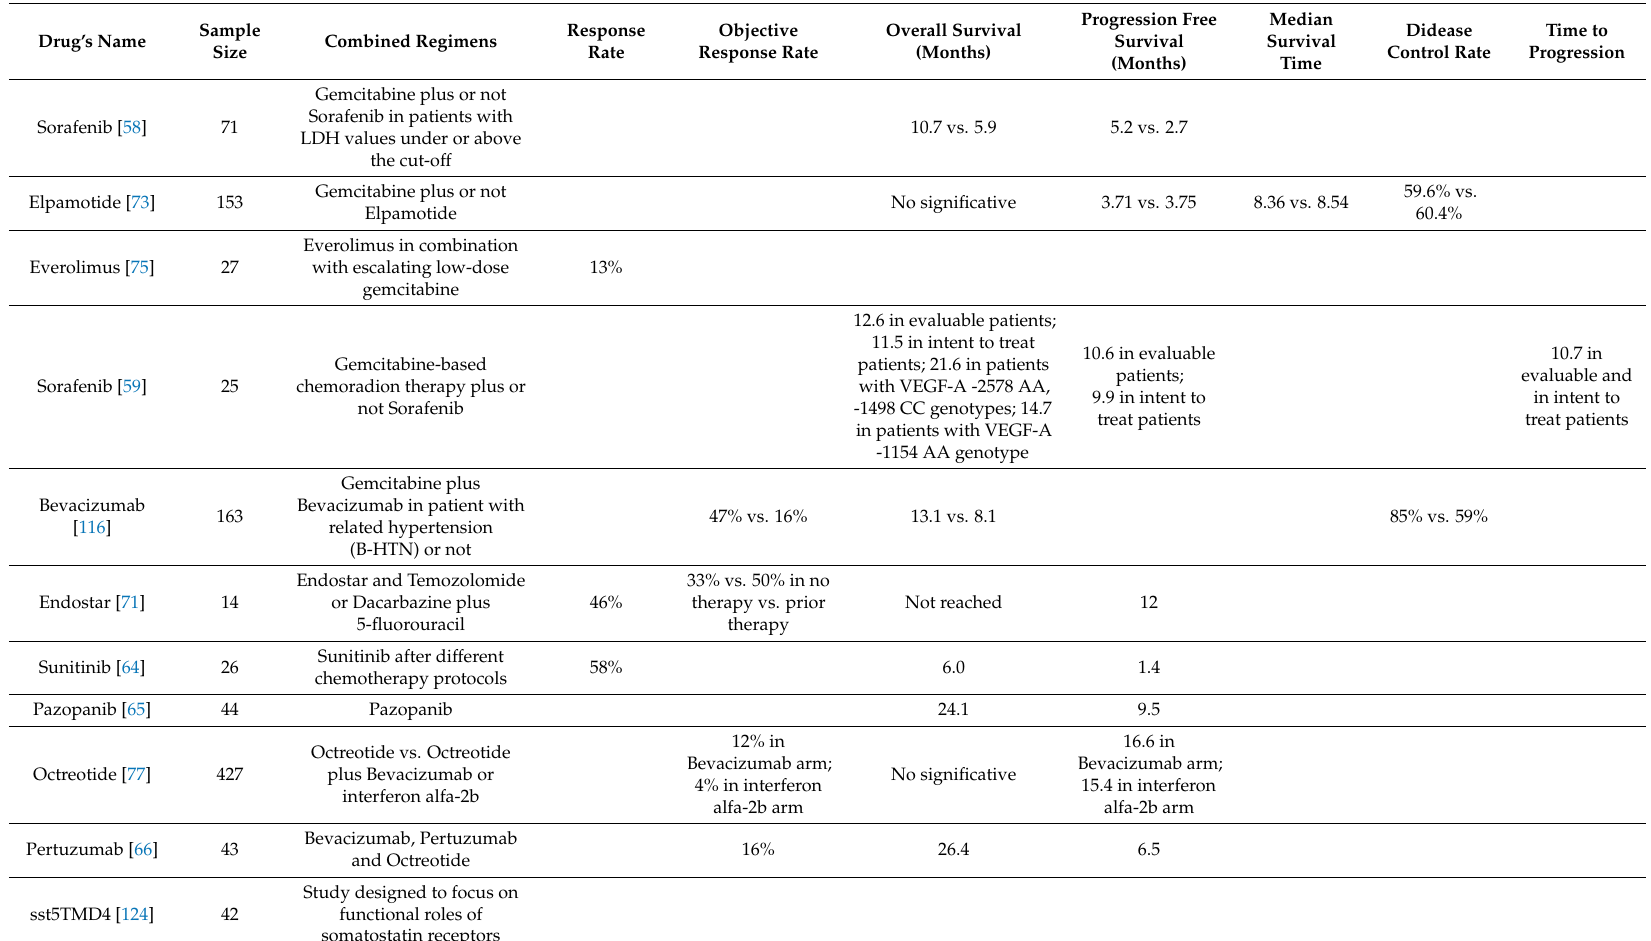
Table 3. Main clinical studies ongoing in pancreatic cancer of last 5 years discussed in the